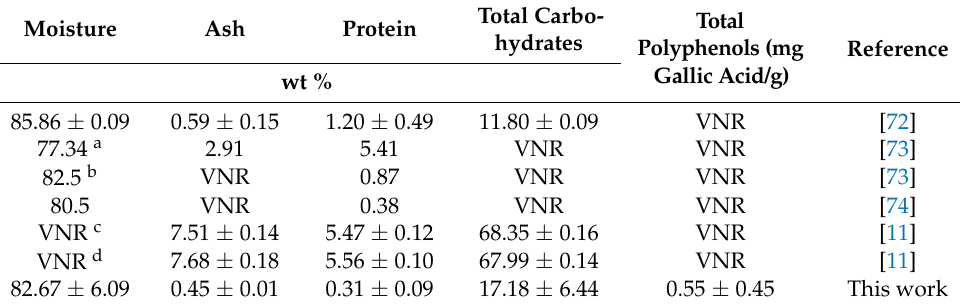
Table 6. Average proximate analysis for CME from cacao fruit samples of various origins and this